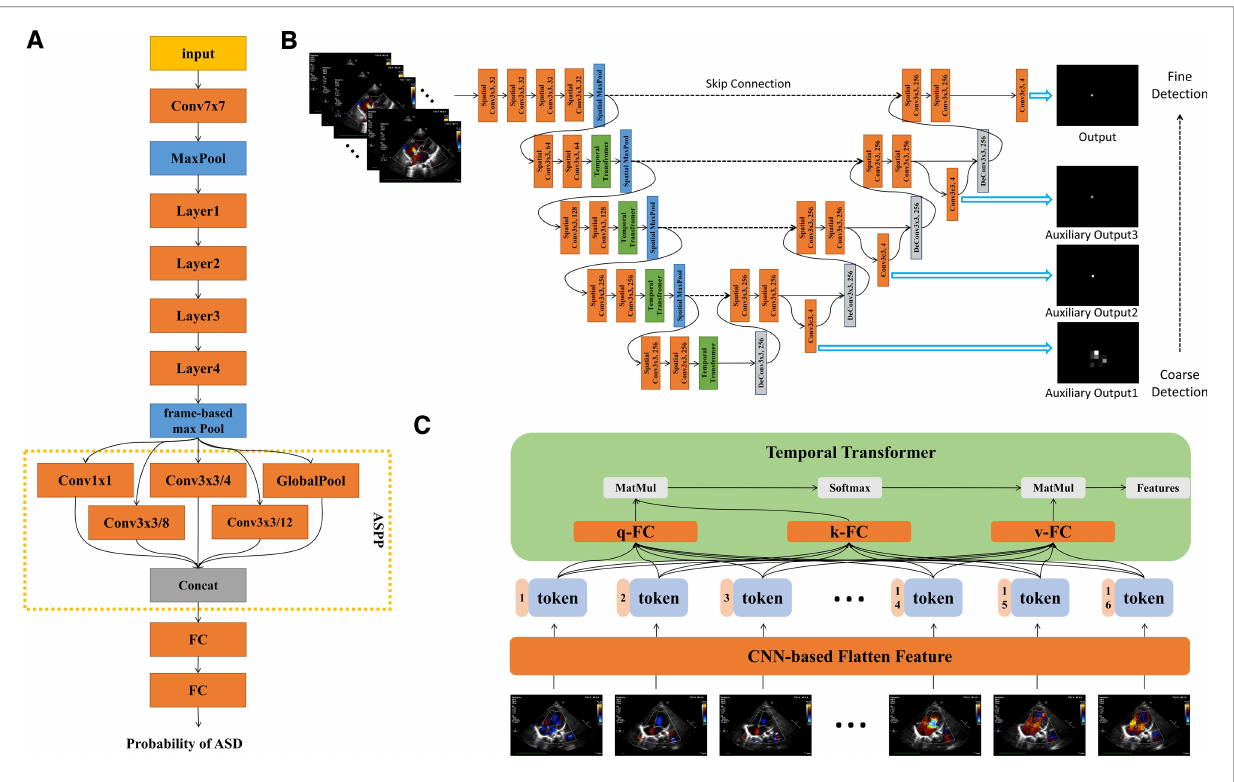
FIGURE 3 Detailed description of model architecture. ( A ) ASD detection neural network architecture, based on Resnet-18, combined with ASPP to increase visual fi eld. The output of the model is the probability of ASD between 0 and 1. ( B ) ASD quanti fi cation neural network architecture, combining spatial convolution and temporal transformer, had three auxiliary outputs and one output from coarse to fi ne. Each auxiliary output is added to the feature map as an additional feature. ( C ) Structure diagram of temproal transformer. Each frame is encoded into a feature token by CNN. Self-attention could realize the long-distance dependence between frames. q , query; k , key; v ,